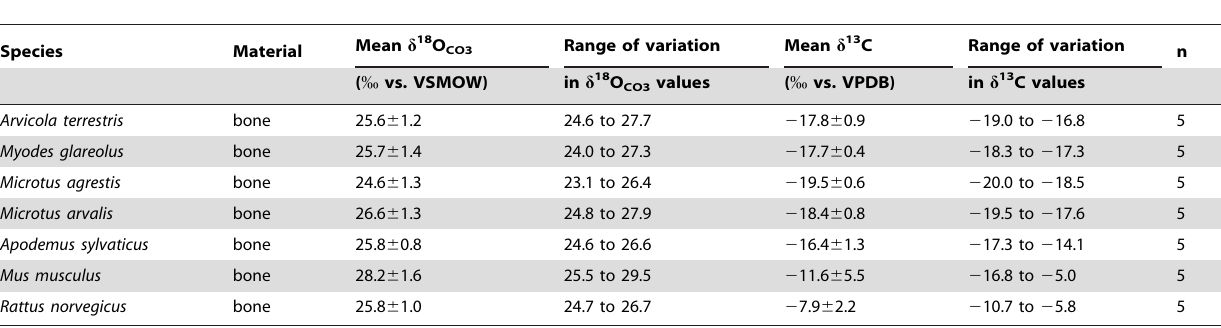
Table 2. Mean d 18 O CO3 and d 13 C values of bone material of the seven analysed rodent species (n= 5 in each species) with 1 s error and range of variation (lowest and highest analytical value of the respective